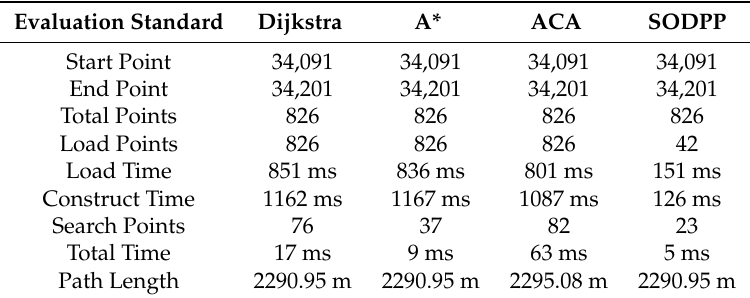
Table 2. Comparison of results for Experiment